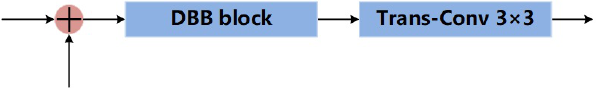
Figure 6. Structure of the decoding.